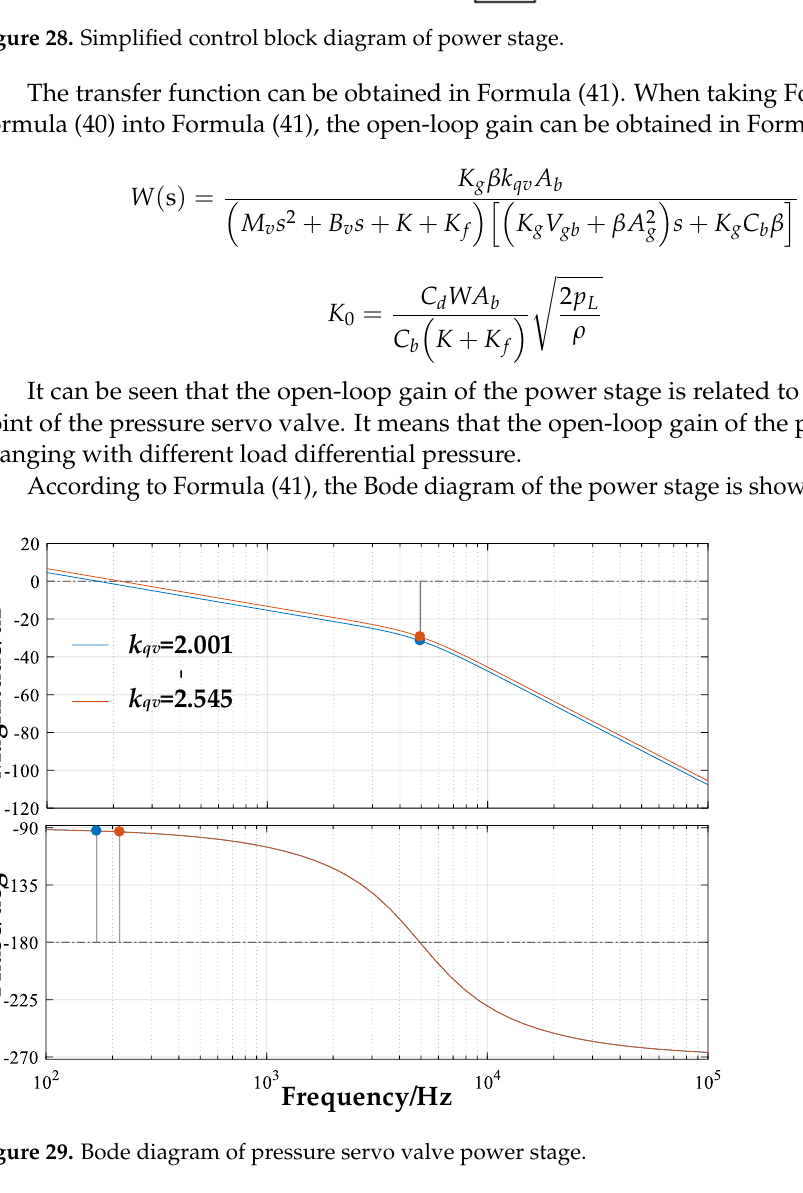
Figure 29. Bode diagram of pressure servo valve power stage. The stability margin of the power stage is shown in Table